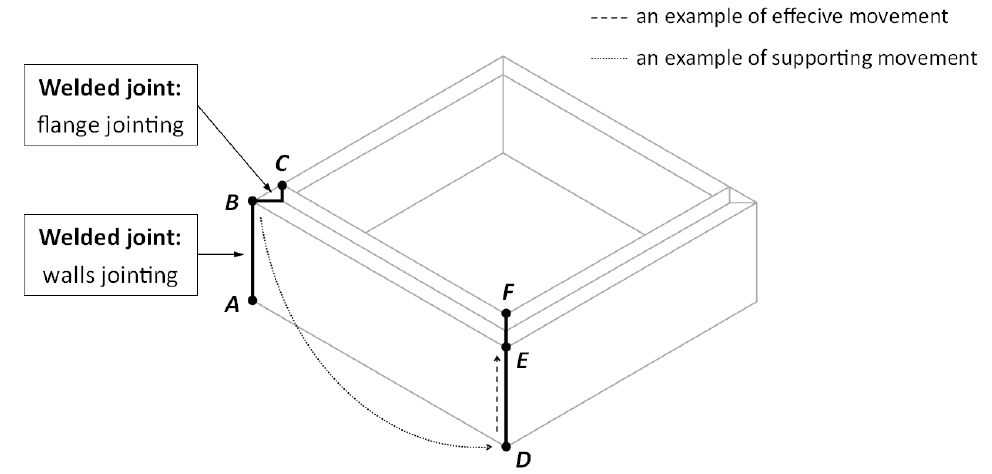
Figure 2. Joints in a single position.